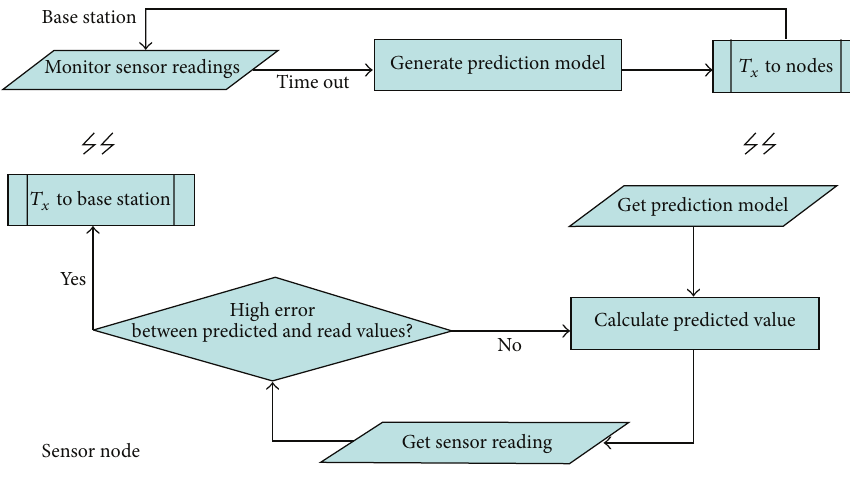
Figure 2: PREMON